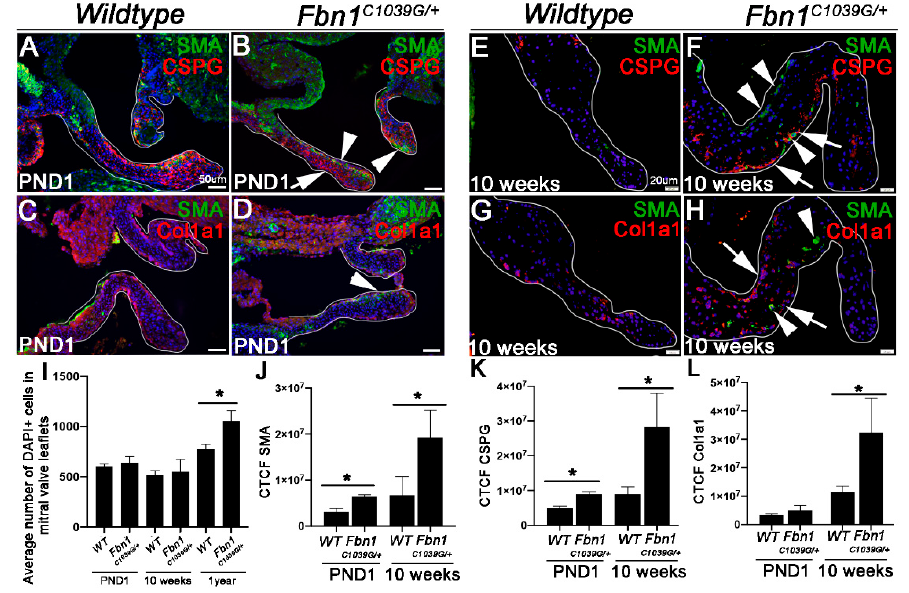
Figure 2. Extracellular matrix markers of myxomatous degeneration are increased in Fbn1 C1039G /+ mice from postnatal day 1 (PND1) and associated with ectopic α -smooth muscle actin (SMA) expression. SMA (green) and chondroitin sulfate proteoglycan (CSPG, red) immunofluorescent co-staining in mitral valves (outlined in white) from wild type (WT) ( A , E ) and Fbn1 C1039G /+ mice ( B , F ) at postnatal day 1 (PND1) ( A , B ); and 10 weeks ( E , F ) of age. ( C – H ) Double staining of SMA (green) with Col1a1 (red) in mitral valves from wild type (WT) ( C , G ) and Fbn1 C1039G /+ mice ( D , H ) at postnatal day 1 (PND1) ( C , D ); and 10 weeks ( G , H ) of age. White arrowheads indicate SMA immunoreactivity, arrows highlight CSPG or Col1a1 staining; ( I ) average number of DAPI-positive nuclei in mitral valve leaflets from Fbn1 C1039G /+ mice and WT littermates at each time point indicated, n = 3, * p > 0.05, using one-way ANOVA in Fbn1 C1039G /+ mice compared to WT controls; ( J – L ) Corrected Total Cell Fluorescence (CTCF) quantification of SMA ( J ); CSPG ( K ) and Col1a1 ( L ) immunoreactivity in mitral valve leaflets from Fbn1 C1039G/+ mice and WT controls at PND1 and 10 weeks. n = 3, * p > 0.05, using a Student’s t-test in Fbn1 C1039G/+ mice compared to WT controls.